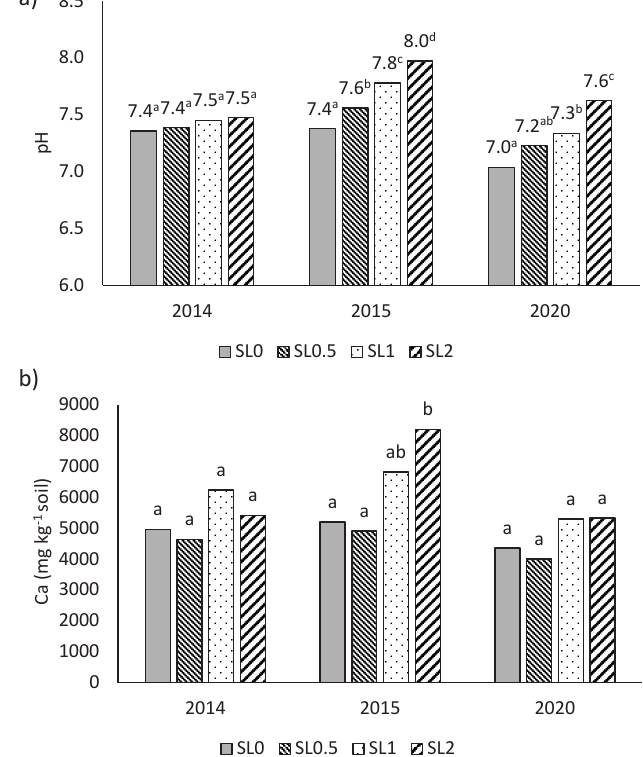
Fig. 2. (a) Soil pH and (b) ammonium lactate-extracted calcium (Ca-AL) content before structure liming (2014), one year after liming (2015) and six years after liming (2020) in the unlimed control (SL0) and in treatments receiving 4, 8 and 16 t ha -1 structure lime (SL0.5, SL1 and SL2, respectively). Mean for all eight field trials. Different letters on bars indicate significant differences between treatments within the